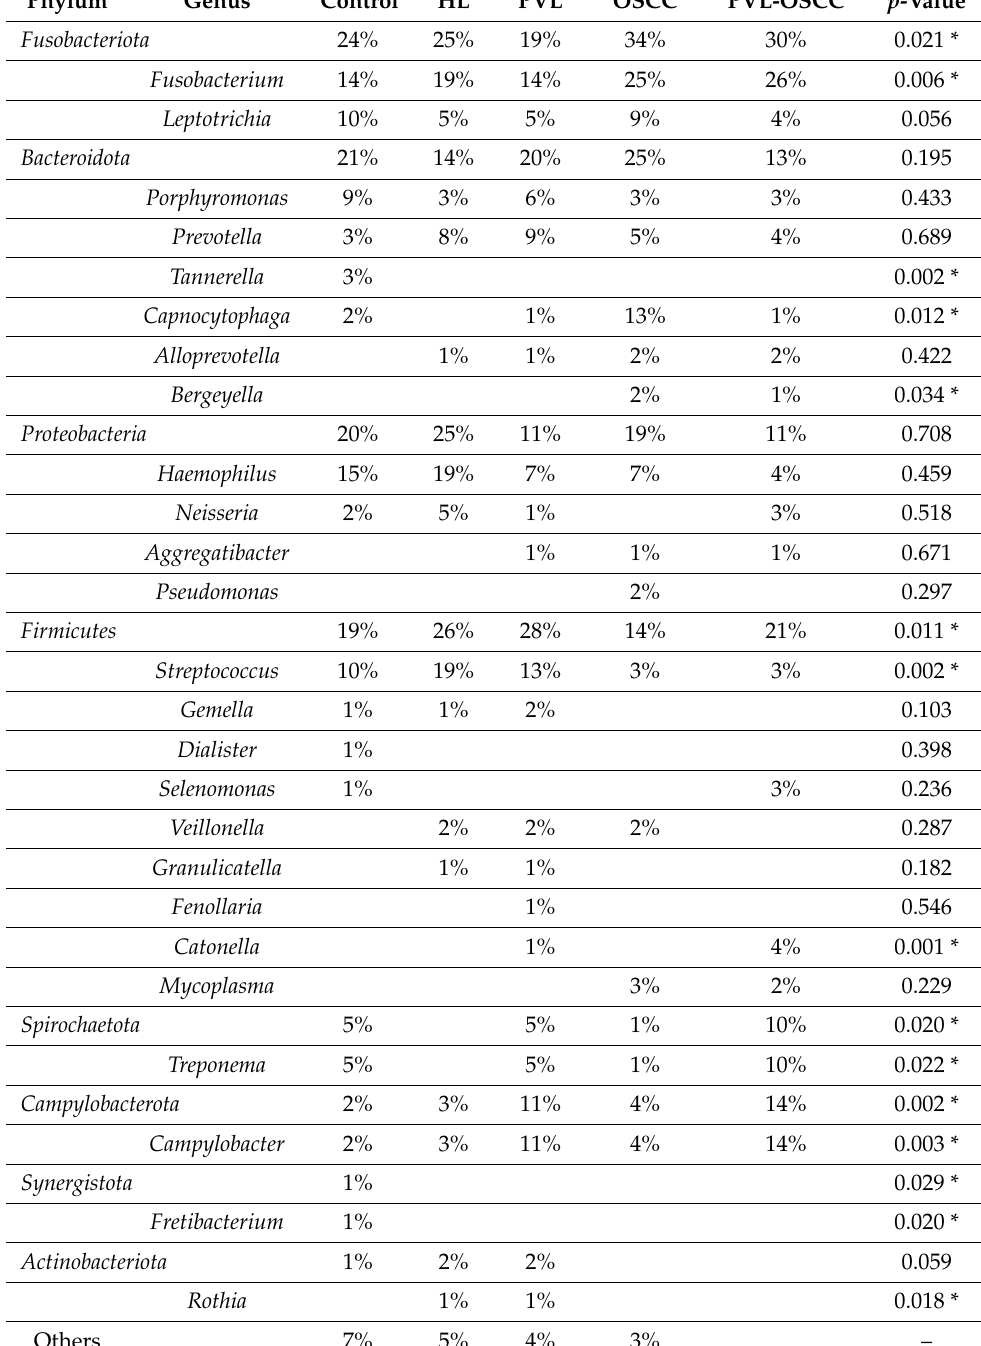
Table 1. Phylogenetic composition of the most common taxa by group. Abundances at the phylum and genus levels are presented as a percentage of the total microbiome. Abundances < 1% are presented as empty cells. Asterisks indicate p <